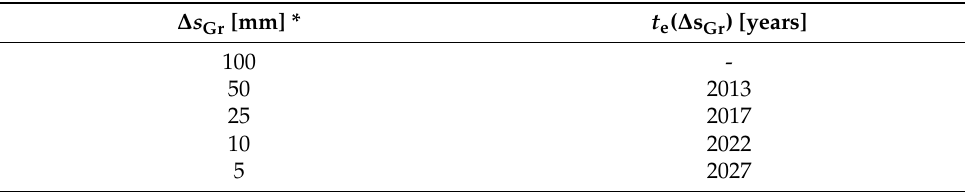
Figure 8. Results of calculations of total subsidence for measurement points 4208900006, 4208900008, and 4208900318 (blue line—measured subsidence; orange markers—predicted residual subsidence).